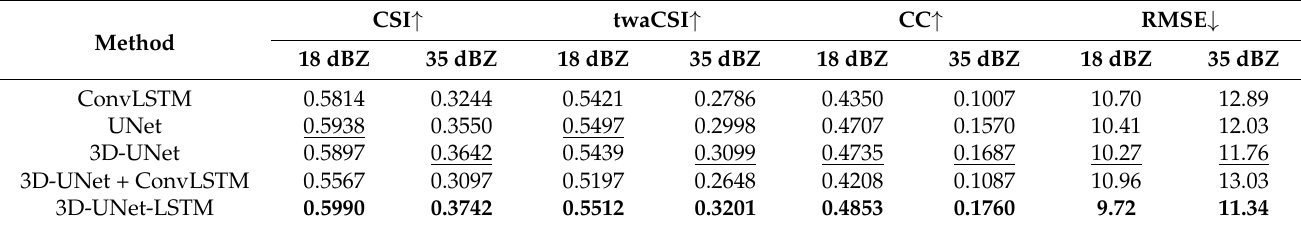
Table 4. Quantitative evaluation of the model design.